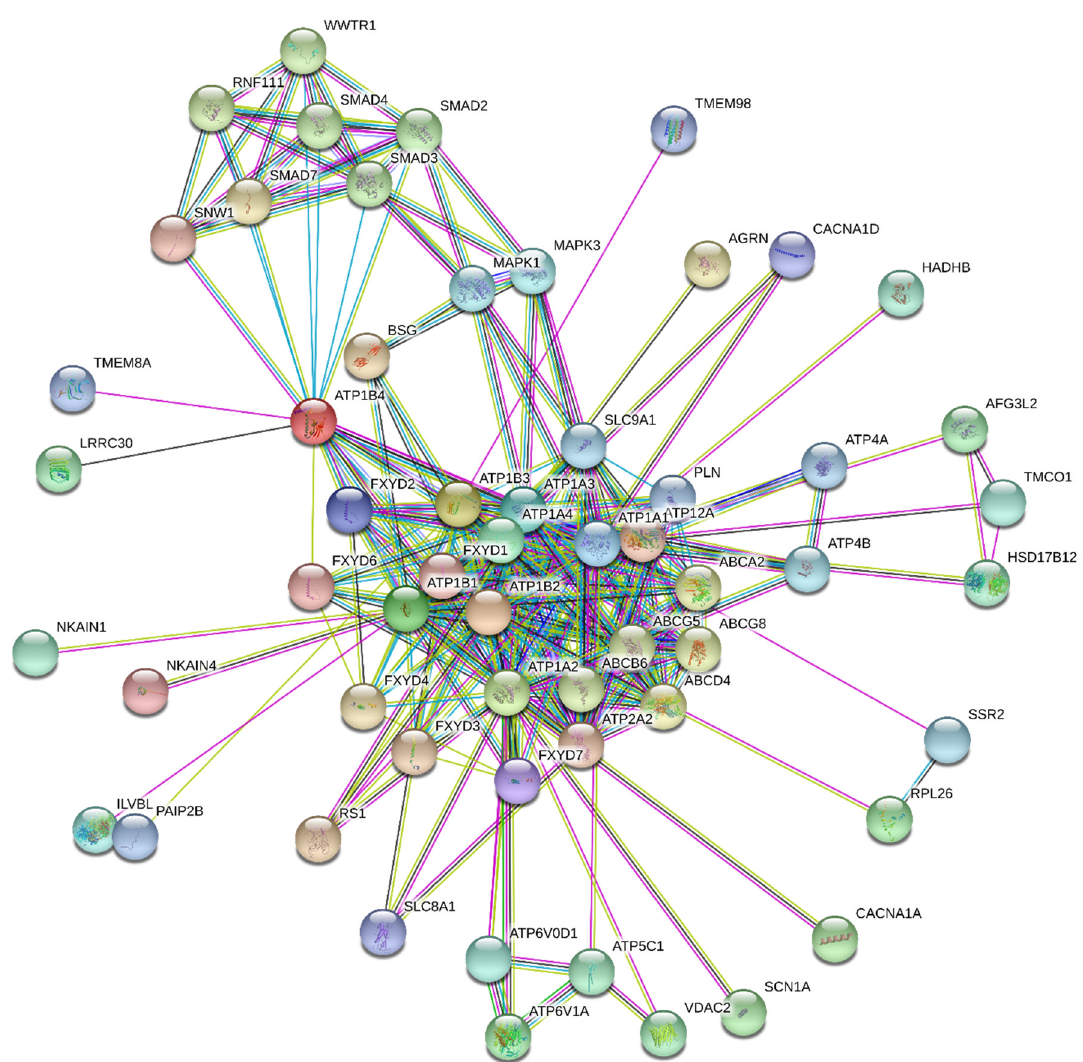
Figure 6. Predicted functional association network for sodium-potassium ATPase (NKA) isoforms (ATP1B4, ATP1B2, ATP1B3, ATP1A2, ATP1B1, ATP1A4, ATP1A3, ATP1A1) created by STRING 11.0 database [128]. The nodes represent gene products depicted in an evidence view mode. The type of the lines indicates knowledge or prediction of the protein-protein associations: Turquoise = from curated databases, pink = experimentally determined, green = gene neighborhood, red = gene fusions, blue = gene co-occurrence, yellow = text mining, black = co-expression, violet = protein homology. The NKA isoforms association network was generated for Homo sapiens species with the confidence score set to 0.700 with a maximum of 50 interactions. Small and large nodes represent proteins with unknown and known or predicted 3D structures, respectively. A description of the listed gene products is in Supplementary Information Table S1.